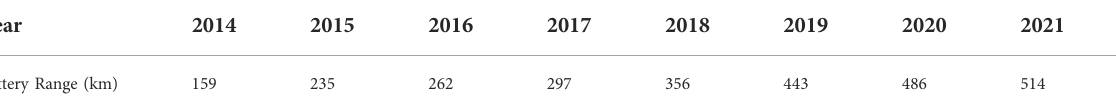
TABLE 2 The battery range of BEV in 2014 – 2022.